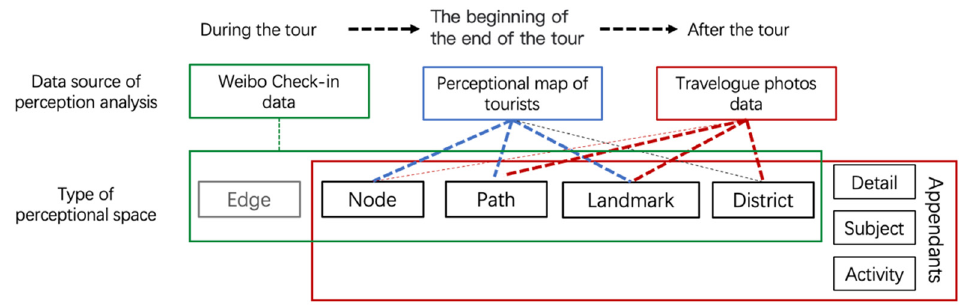
Figure 13. Spatial cognitive preference of tourists in Fengjing Ancient Town (source: